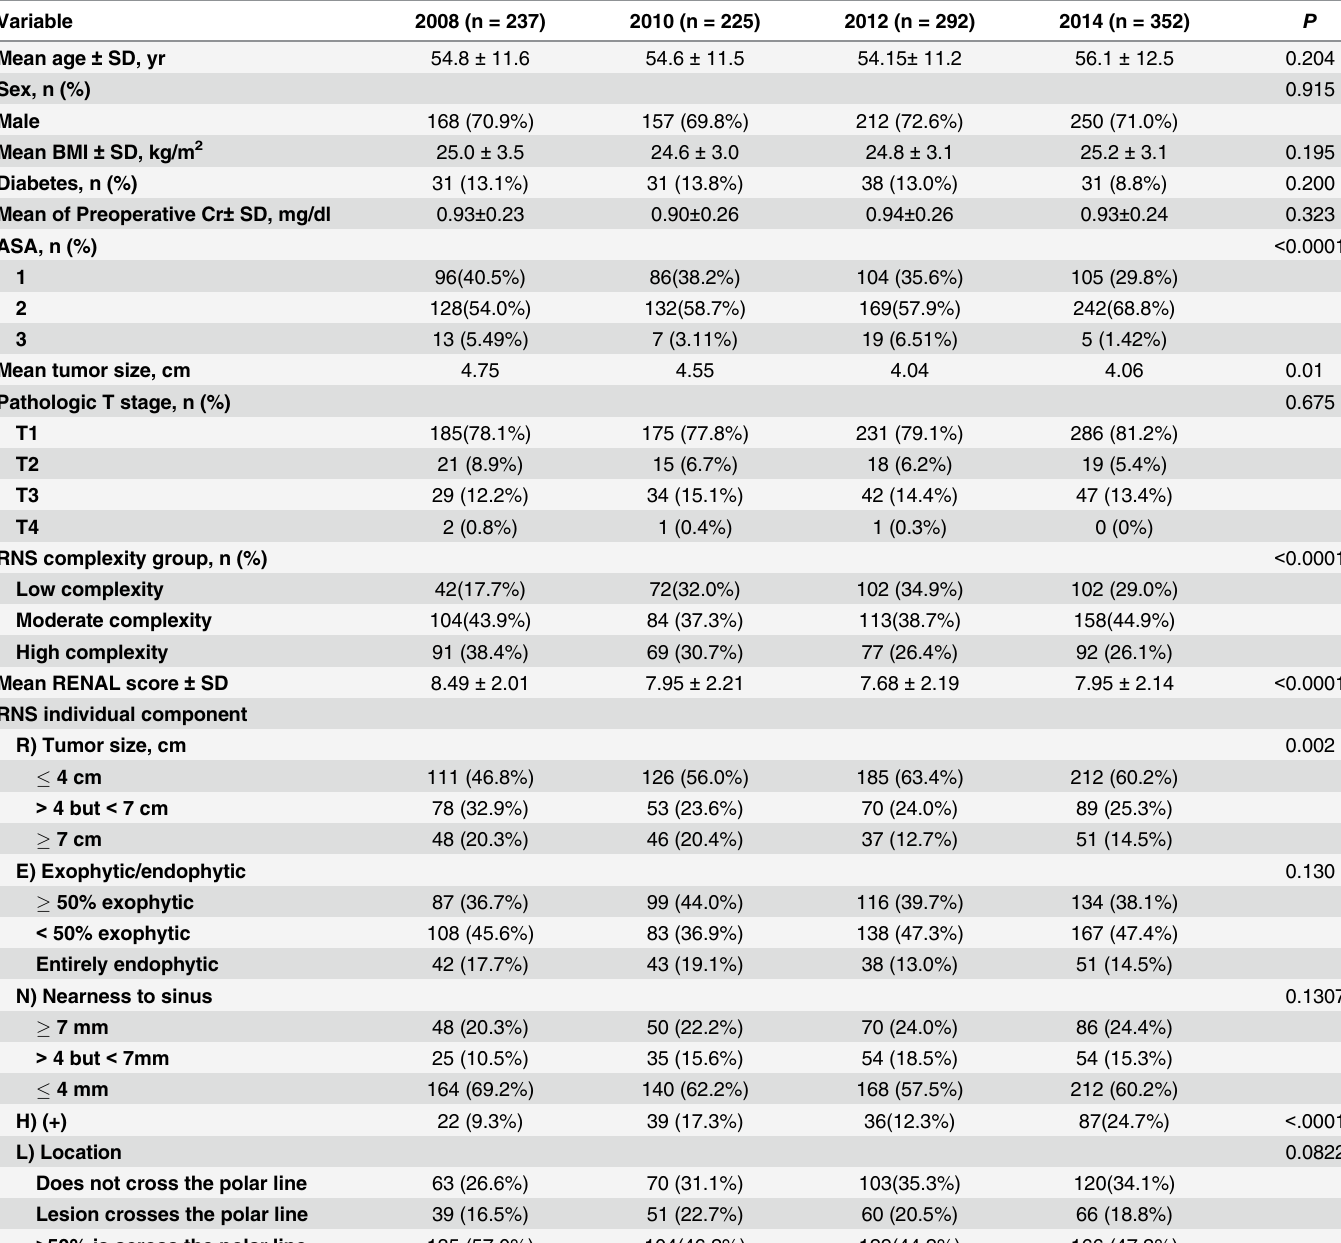
Table 1. Clinical and radiographic data for 1106 patients treated surgically for